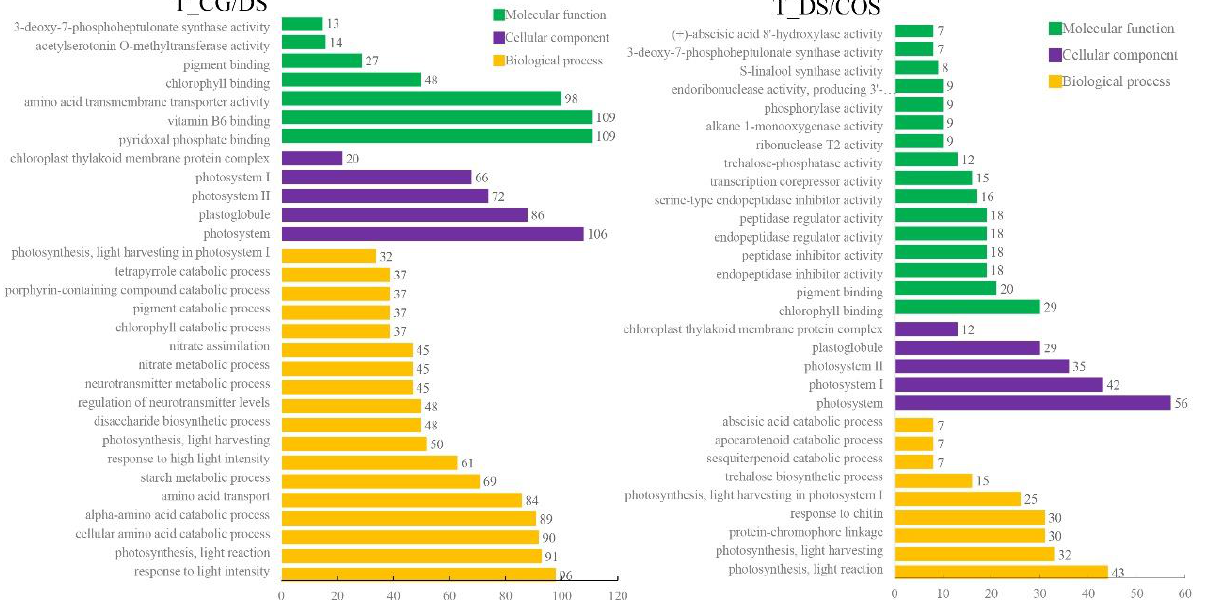
Figure 2. Top-30 GO pathway enrichment of DEGs in the DS and COS treatment groups compared to the control group (CG/DS; left panel) and to each other (DS/COS; right panel). Numbers beside the columns indicate the number of DEGs in that pathway. Green, purple, and yellow bars represent molecular function (MF), cellular component (CC), and biological process (BP), respectively.